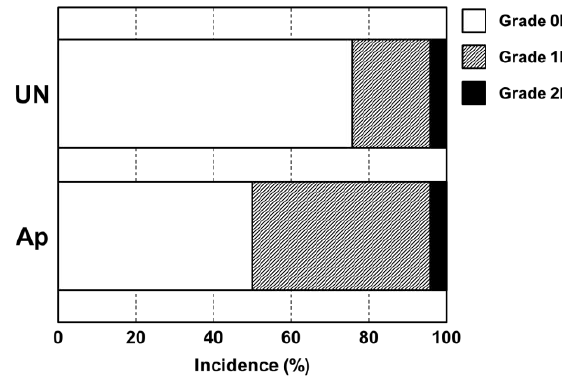
Figure 7. Comparison of differences in osteomyelitis grades classified according to histological observations between the UN and Ap groups. The apatite layer was formed at 25